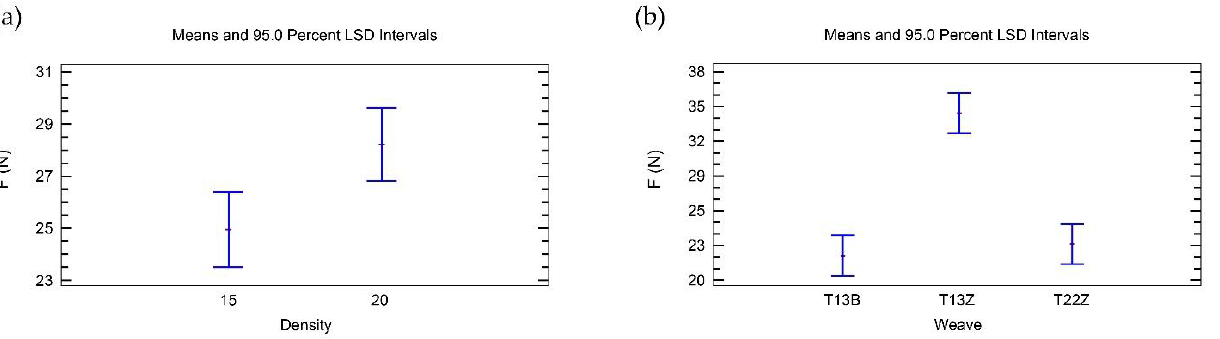
Figure 4. Influence of the main factors on the adhesion force for simple fabrics for z2: ( a ) density; ( b ) weave.